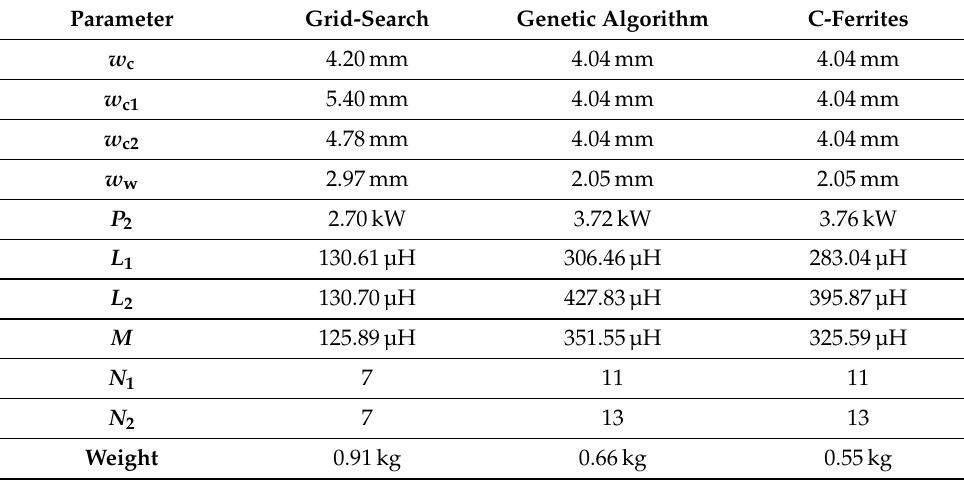
Table 1. Comparison between the results obtained in the three optimization procedures. Parameter Grid-Search Genetic